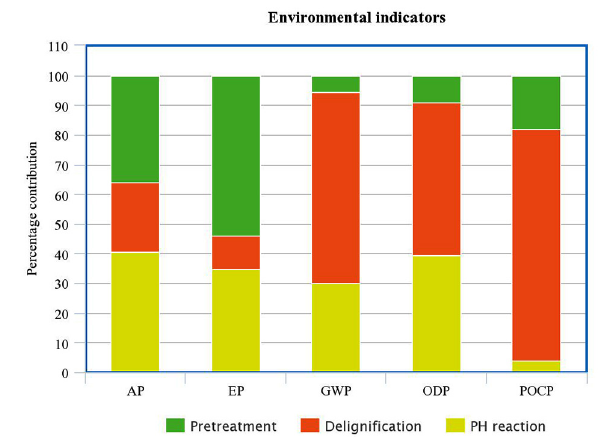
Figure 4. Percentage contributions of pretreatment, delignification and photocatalytic hydrolysis towards AP, EP, GWP, ODP and POCP